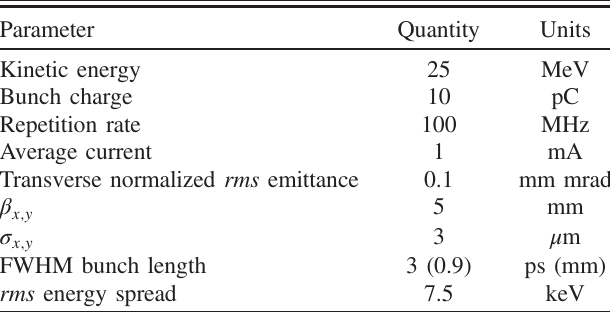
TABLE I. Desired electron beam parameters at interaction point.